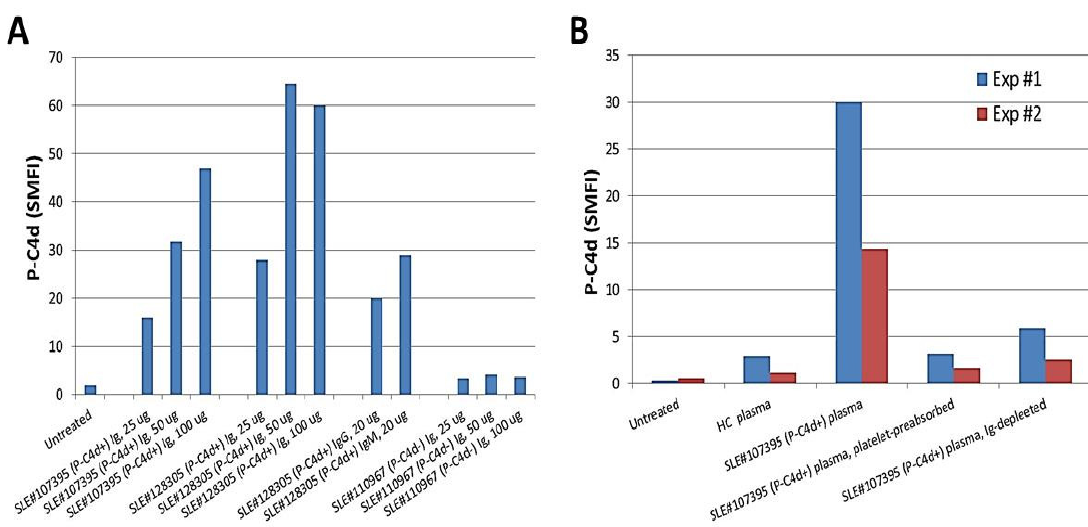
Figure 3. Presence of platelet ‐ reactive autoantibodies in plasma of SLE patients. (A) Platelets from a healthy control were incubated with different amounts of immunoglobulins purified from two representative P ‐ C4d+/aPL+ SLE patients (#107395 and #128305), and from a representative P ‐ C4d ‐ two representative P-C4d+/aPL+ SLE patients (#107395 and #128305), and from a